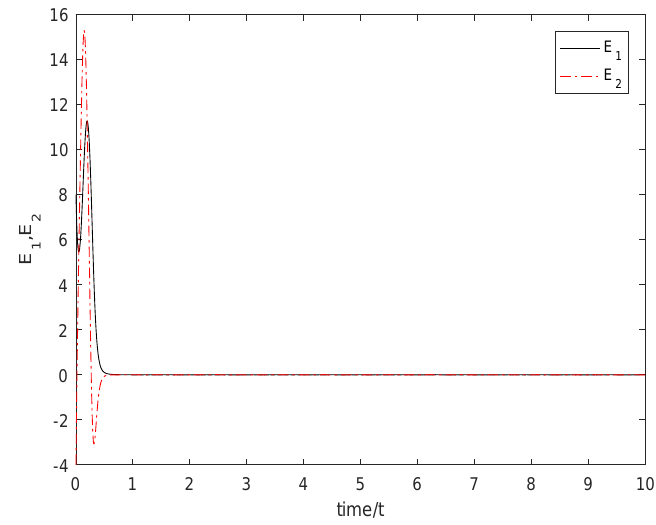
Figure 2. The sum subsystem (36) is asymptotically